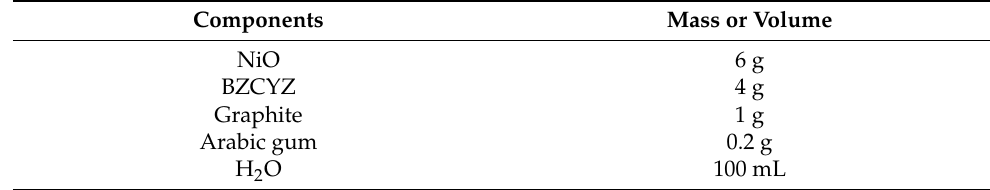
Figure 6. ( a ) Flowchart of tubular SOC fabrication: 1. Slurry ball milling; 2. Slip casting; 3. Fettling and sintering; 4. Dip coating; 5. Electrolyte layer sintering; 6. Cathode preparation and sintering; 7. Current collection preparation. ( b ) Sintering process of fuel electrode support, electrolyte, and air electrode. Table 1. Composition of NiO-BZCYZ fuel electrode support slurry.